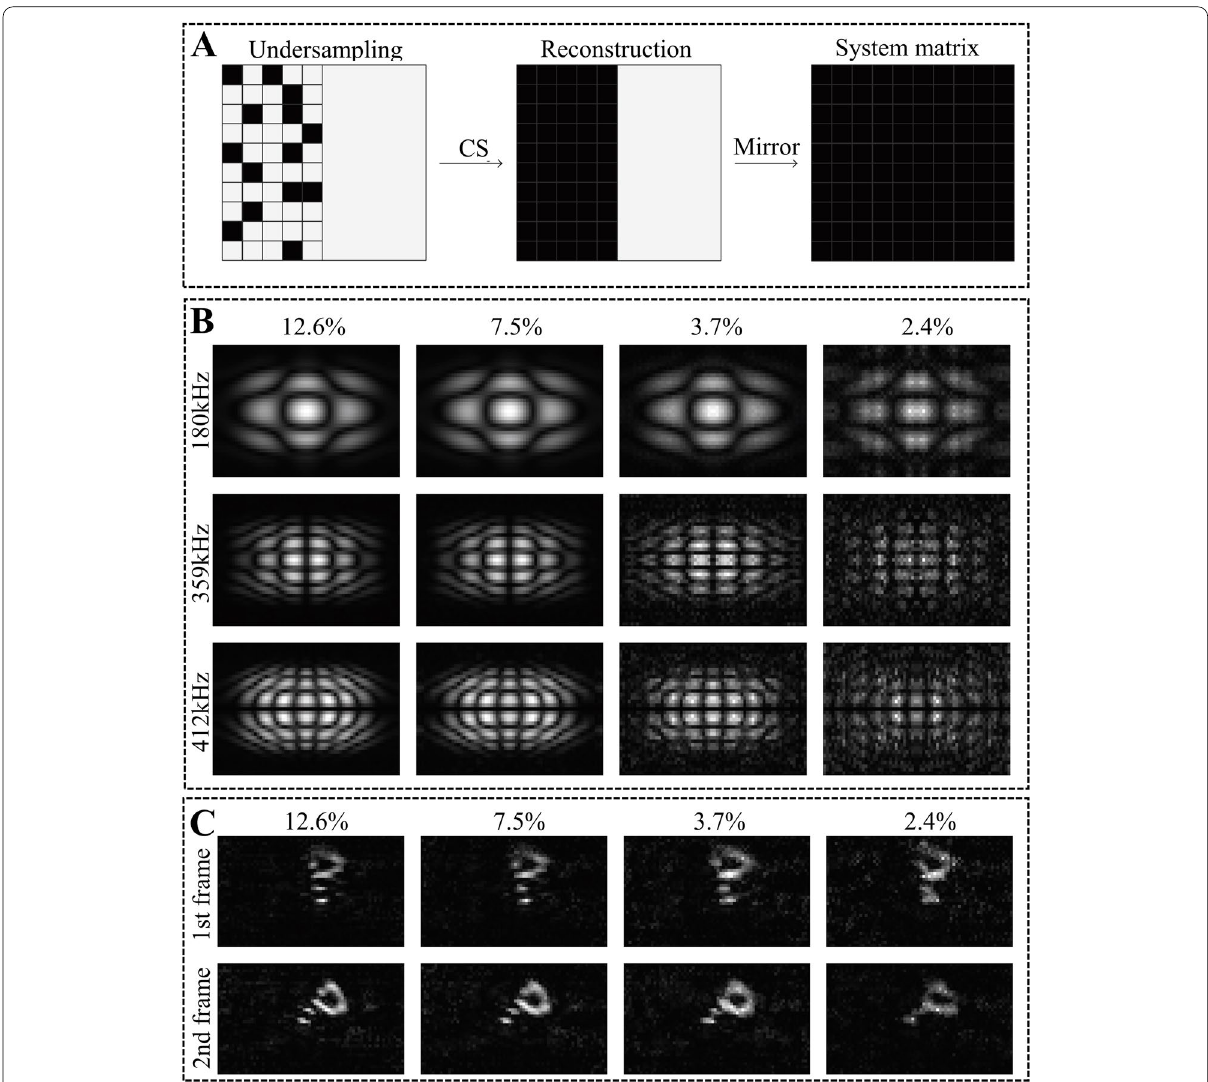
Fig. 4 A The principle of the CS-symmetry method: the first half of the SM is recovered based on the CS method. Then, the complete SM is recovered based on mirror symmetry (alternatively, by changing the order of the two steps, symmetry-CS is permissible). B The SM components at different frequencies recovered with the symmetry-CS method at different sampling rates. C Reconstructed phantom results of the recovered SM at different sampling rates based on the symmetry-CS method. For more images see ref.